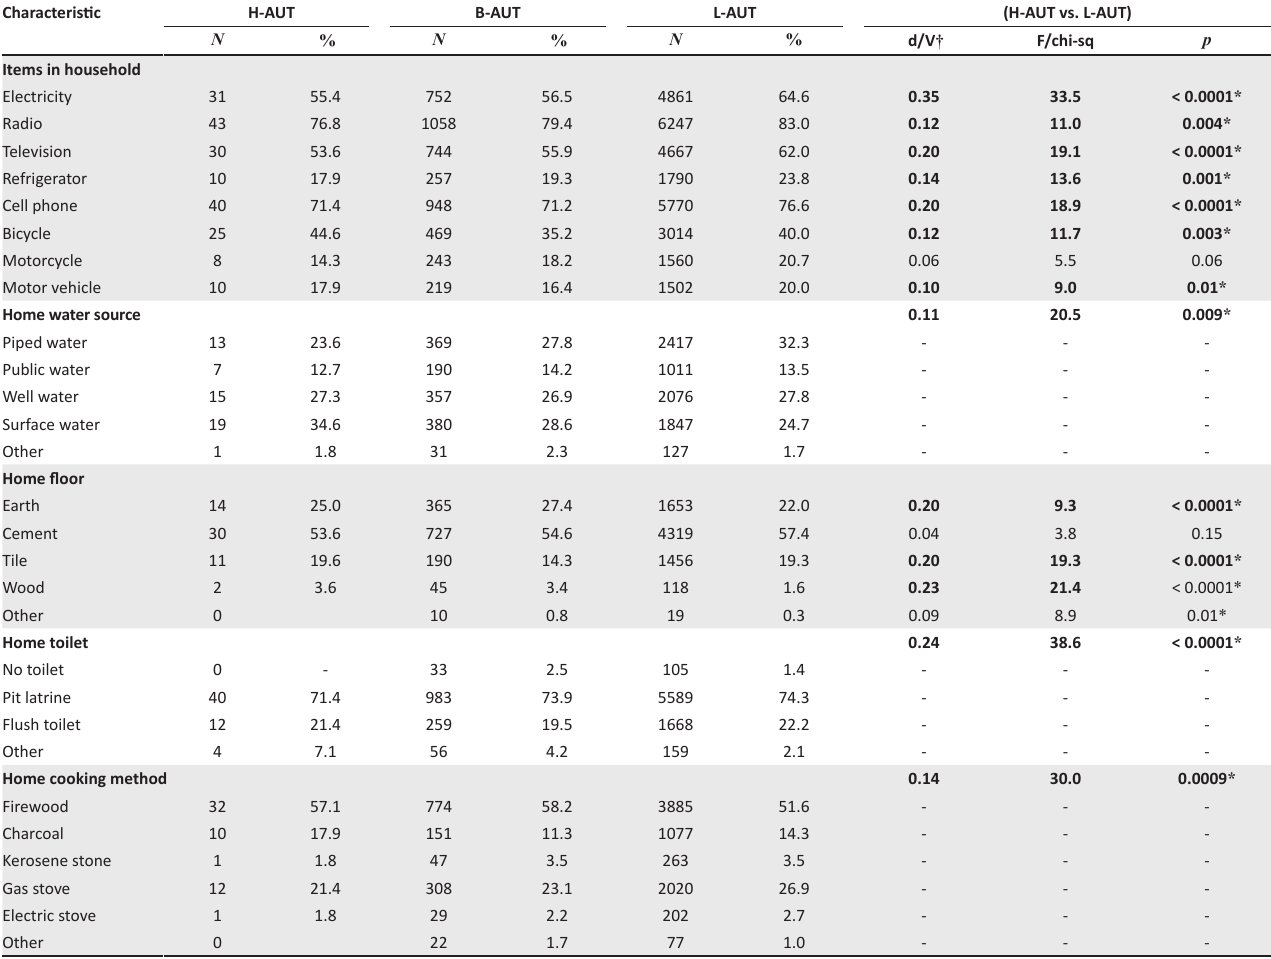
TABLE 2: Economic characteristics of participant groups ( N = 8918).